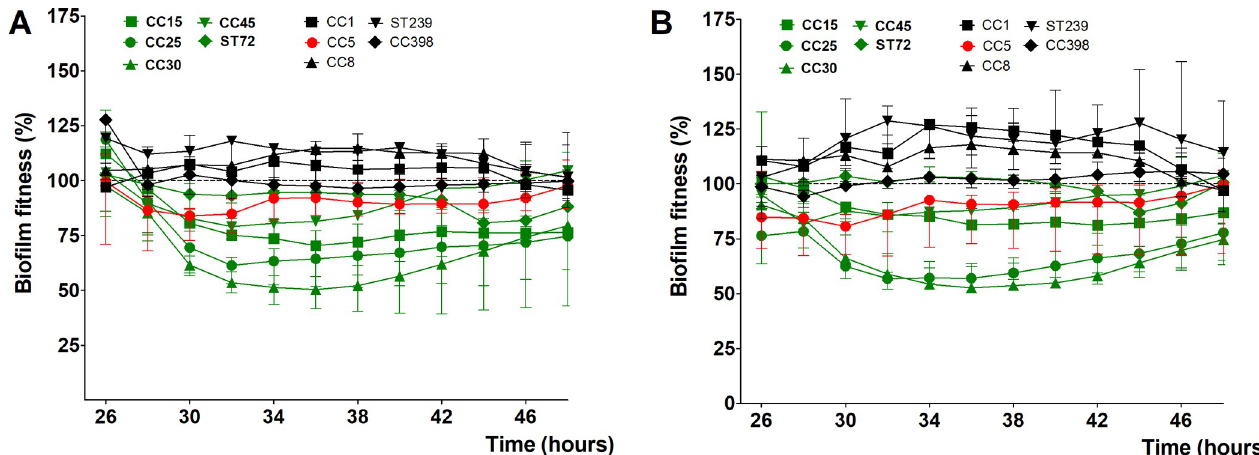
Fig 4. Staphylococcus aureus biofilm sensitivity to cephalosporins. The 24 hours kinetic of biofilm fitness of MSSA (CC15, CC25, CC30, CC45, and ST72) and MRSA (CC1, CC5, CC8, ST239, and CC398) strains towards 8 μ g/mL cefuroxime (CXM) (A) and 16 μ g/mL cefotaxime (CTX) (B) relative to untreated biofilm fitness. In both figures Mu50 (CC5) was used as non-susceptible control. Dashed horizontal lines indicate control (untreated biofilm). Error bars represent median with range (n = 3).